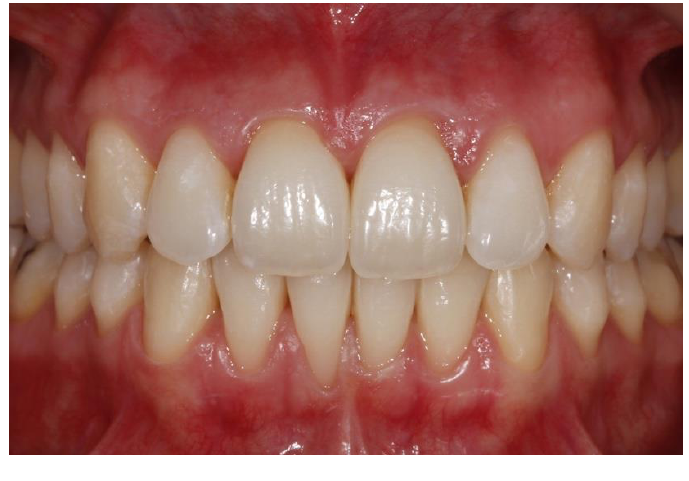
Figure 6. Group 4 patient (40% HP, Boost, Ultradent): ( A ) pre-treatment image; ( B ) post-treatment image. Figure6. Group4patient(40%HP,Boost, Ultradent): ( A )pre-treatmentimage; ( B